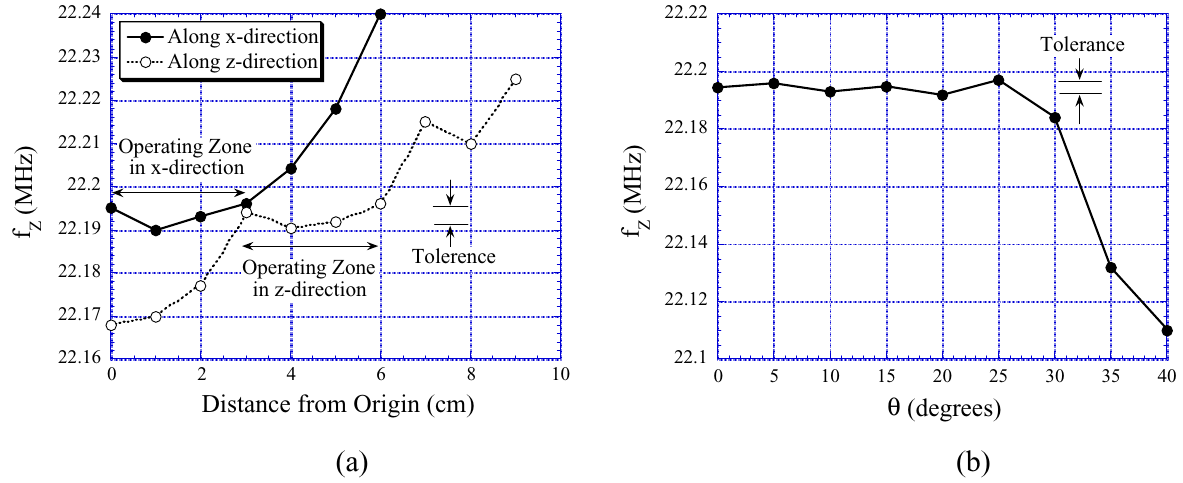
Figure 12. (a) The shift in f of the sensor in the x direction (solid line) when the sensor is z 3 cm from the xy -plane, and the shift in f in the z direction (dashed line) when the sensor is on z the z -axis. (b) The shift in sensor f as a function of θ when the sensor is on the z -axis, 4 cm z away from the